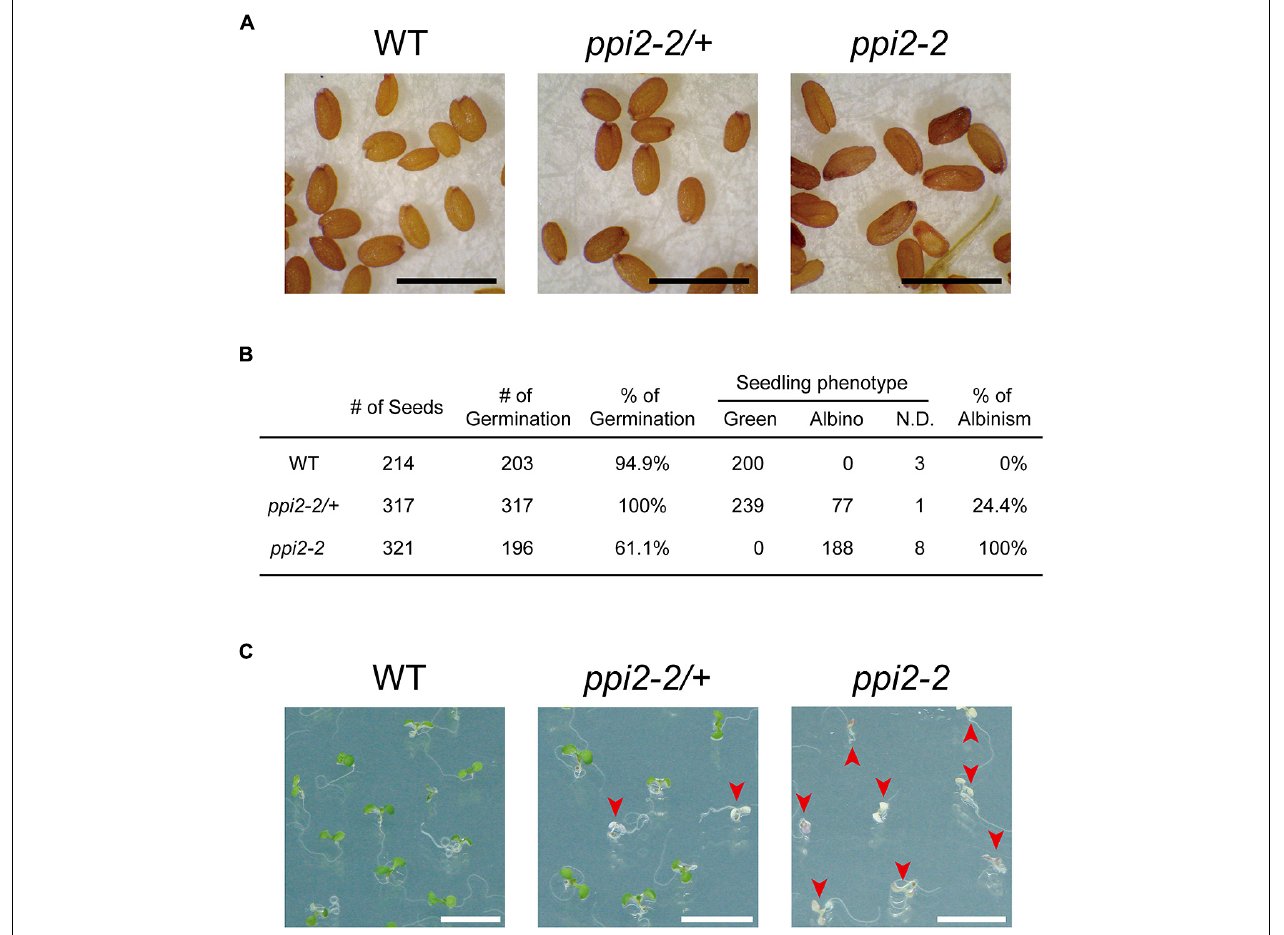
determined 6 days after the transfer of the plates to a growth chamber. Some of those seedlings could not be designated as green or albino due to growth retardation and thus were classified as “not determined (N.D.).” (C) Phenotype of seedlings germinated from wild-type, ppi2-2/ + , and ppi2-2 seeds. Arrowheads indicate albino plants.White bars = approximately 1